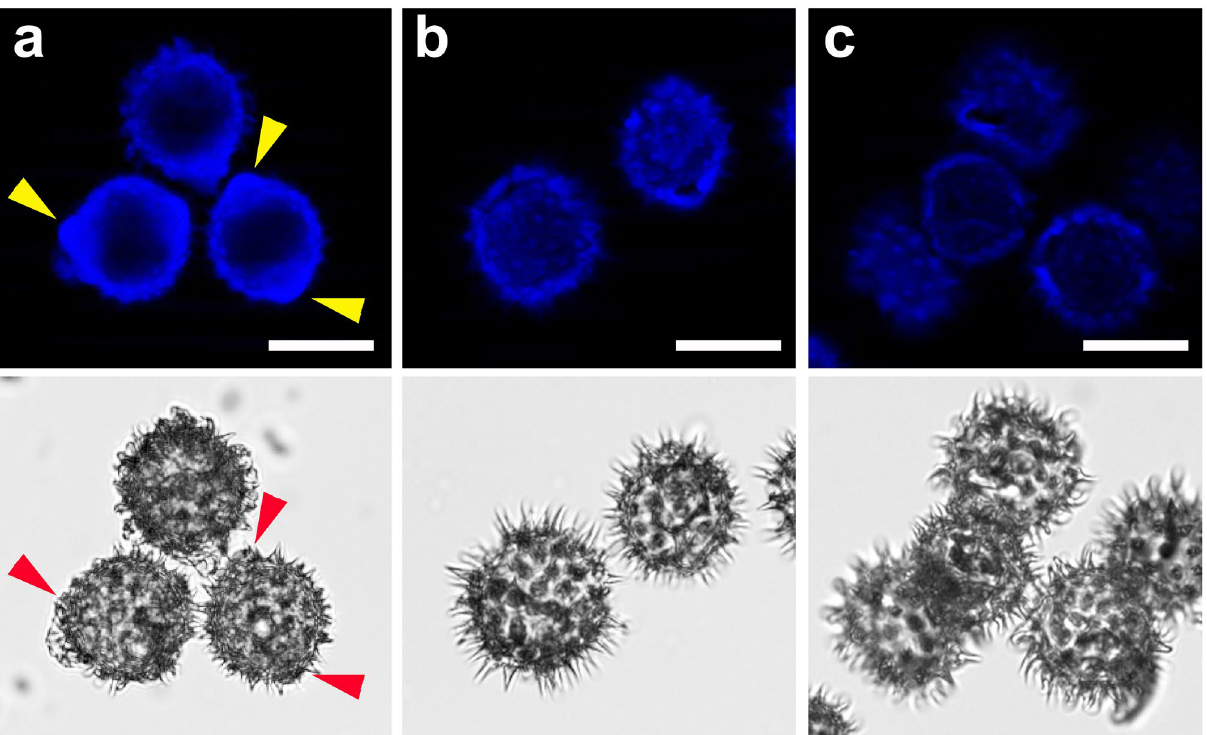
Figure 1. Fluorescence imaging of sunflower and rape pollen grains, with and without the intine wall. The samples were stained with calcofluor white. Pictures in the upper row were taken using mercury lamp excitation and a DAPI filter cube (see the Methods section), while the lower ones with brightfield imaging. Some exine apertures where the presence and absence of the intine can be best observed, are marked by yellow (on fluorescent image) and red (on brightfield image) arrowheads. Scale bars represent 40 μm. ( a ) Sunflower pollen grains P1-purified by Soxhlet extractions and an aqueous wash, without a P2-purification. Note the presence of the protruding intine portions. ( b ) Sunflower pollen grains P1-purified by Soxhlet extractions and an aqueous wash, and P2-purified by enzymatic treatment. Note the absence of the intine. ( c ) Sunflower pollen grains P1-purified by Soxhlet extractions and an aqueous wash, and P2-purified by TBPH. Note the absence of the intine. ( d ) Rape pollen grains P1-purified by Soxhlet extractions and an aqueous wash, without a P2-purification. ( e ) Rape pollen grains P1-purified by Soxhlet extractions and an aqueous wash, and P2-purified by TBPH. Note the absence of the